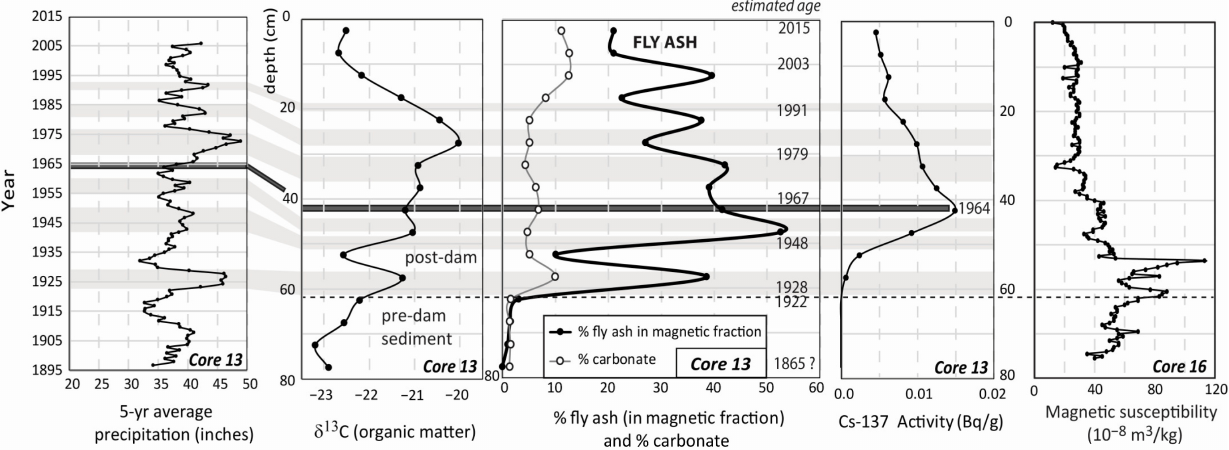
Figure 8. Lake Decatur Core 13: comparison of records of magnetic fly ash, carbonate content, δ 13 C, 137 Cs, and particle